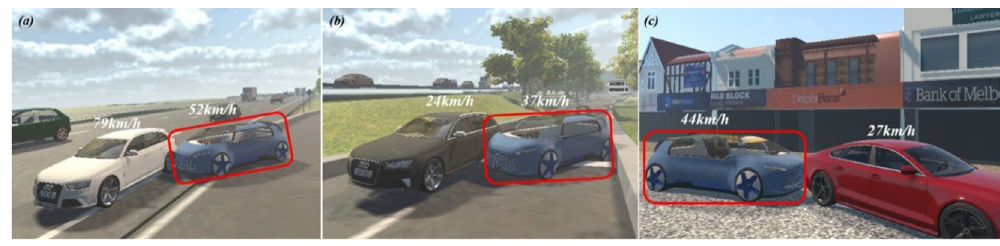
Figure 11 Typical observed